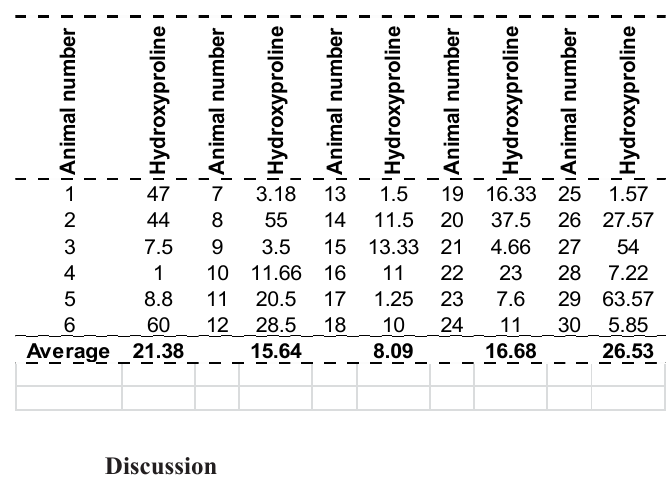
TABLE 1 - Dosage of hydroxyproline in sutures with polypropylene and poliglecaprone